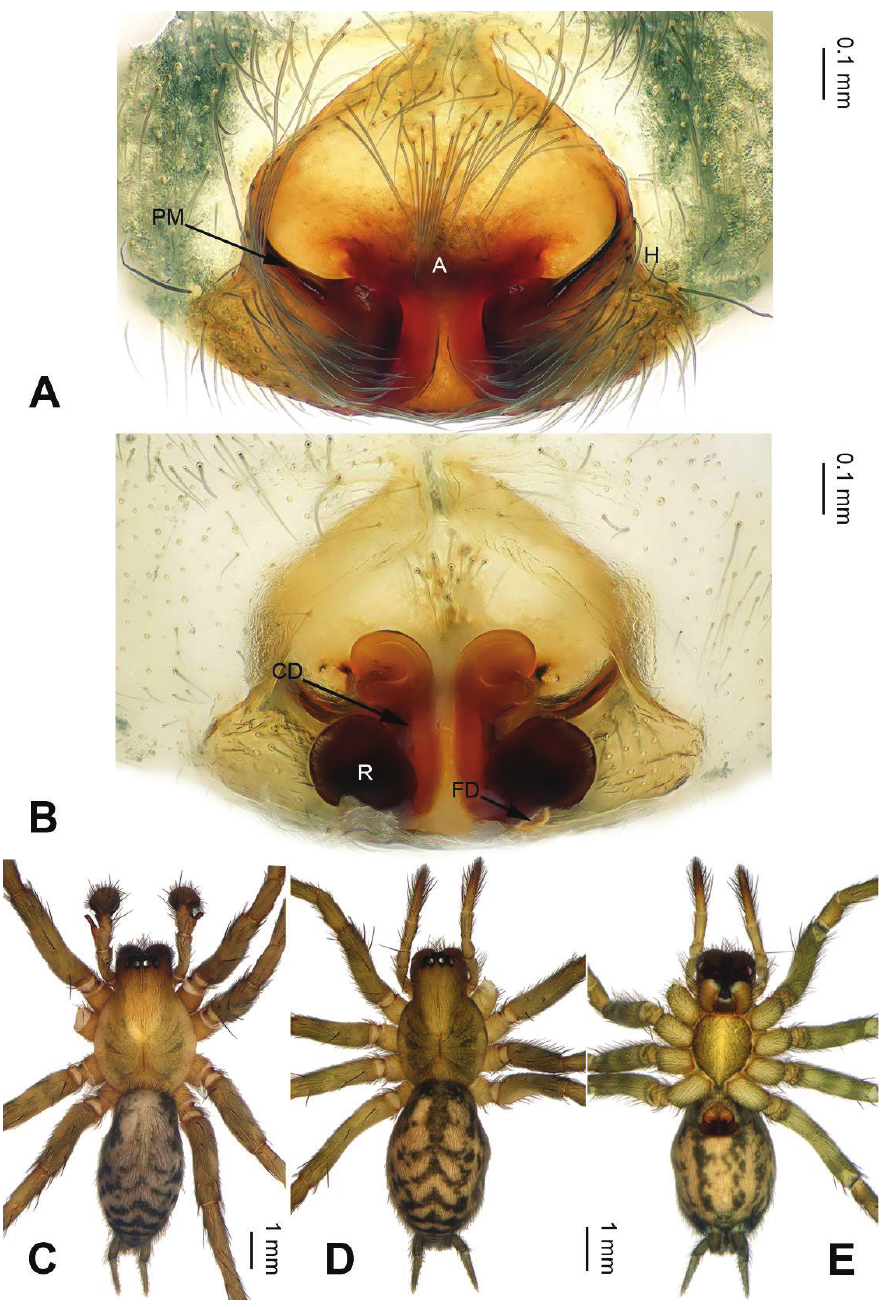
Figure 4. Longicoelotes kulianganus , specimen from Guling. A Epigyne, ventral view B Vulva, dorsal view C Male habitus, dorsal view D Female habitus, dorsal view E Female habitus, ventral view. A = epigynal atrium, CD = copulatory duct, FD = fertilization duct, H = epigynal hood, PM = posterior margin of atrium, R = receptacle. Scale bars: equal for D, E